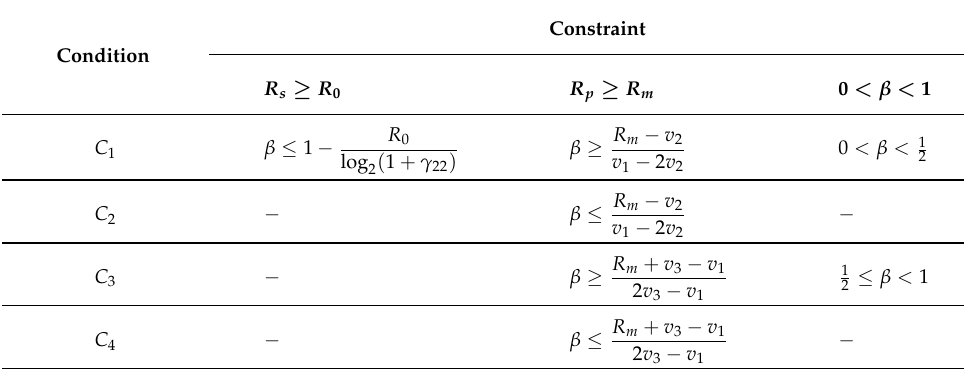
Table 1. Boundary values of β for different conditions in